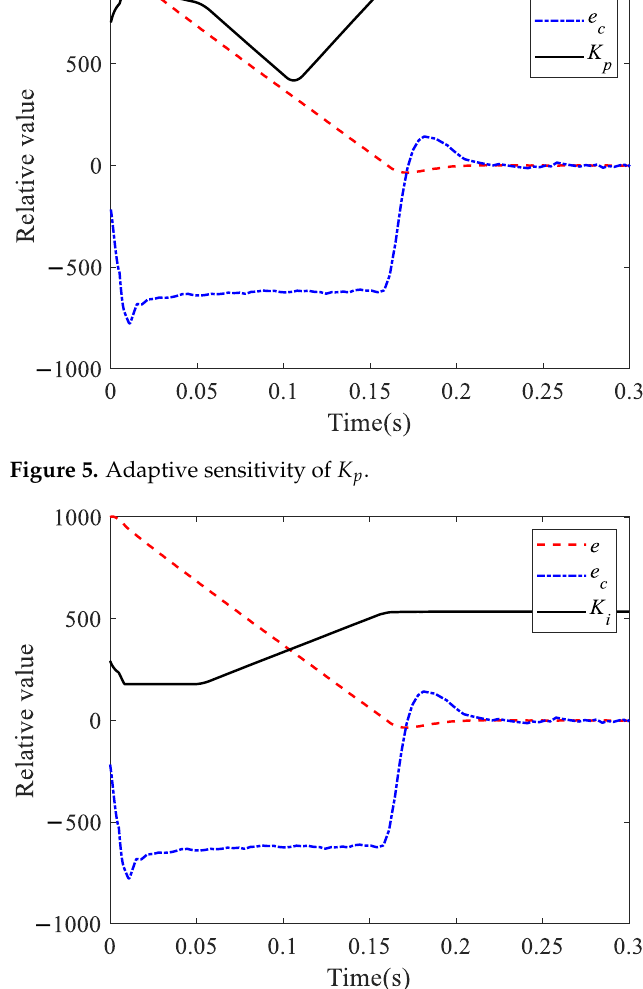
Figure 6. Adaptive sensitivity of K i